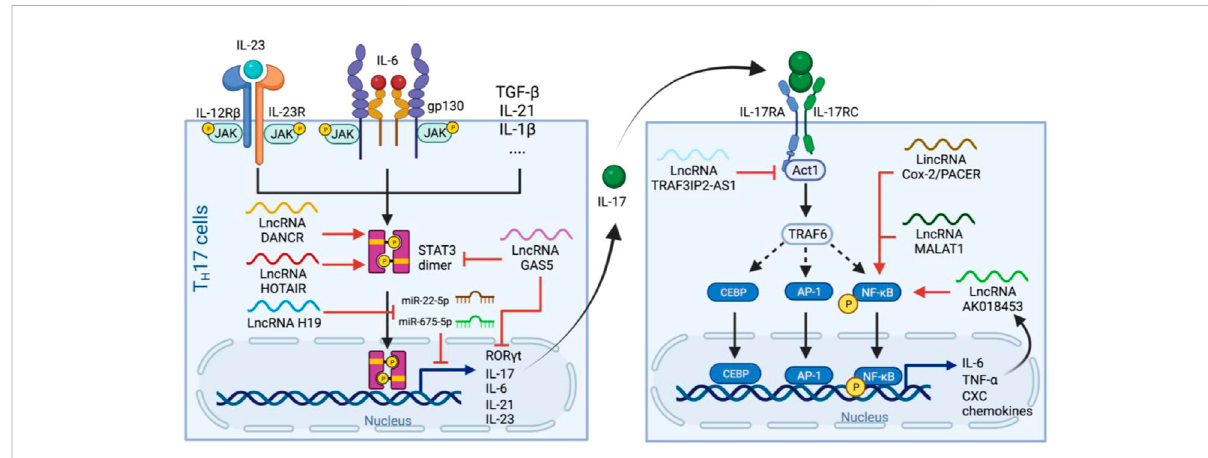
FIGURE 4 Production and signaling pathways ofIL-17and regulatory lncRNAsintheprocess. Leftpanel. T H 17cells differentiateuponreceiving IL-23,IL-6 andothercytokinesignaling.ActivatedIL-6andIL-23receptorsleadstophosphorylationanddimerizationofSTAT3whichsubsequentlyinitiatesthe expression ofgenesrelated toT H 17programming.LncRNAs suchasDANCR andHOTAIRstimulateSTAT3 dimerizationinasimilarmannertothat of in the IL-6 pathway, whereas H19 sponges miR-22-5p and miR-675-5p to stimulate IL-17 production. GAS5 inhibits T H 17 differentiation by promoting STAT3 degradation and suppresses ROR γ t and IL-17 expression. Right panel. IL-17 from T H 17 cells dimerizes and binds to IL-17RA/C, which activates Act1 and then TRAF6 to facilitate nuclear translocation of CBEP, AP-1 and NF- κ B and thus the release of IL-6, TNF- ⍺ and CXCs. This pathway also induces the expression of the lncRNA AK018453, which, together with PACER and MALAT1, enhances NF-kB-mediated IL-17- dependent responses. Whereas TRAF3IP2-AS1 downregulated the expression of Act1 and suppress the effect of